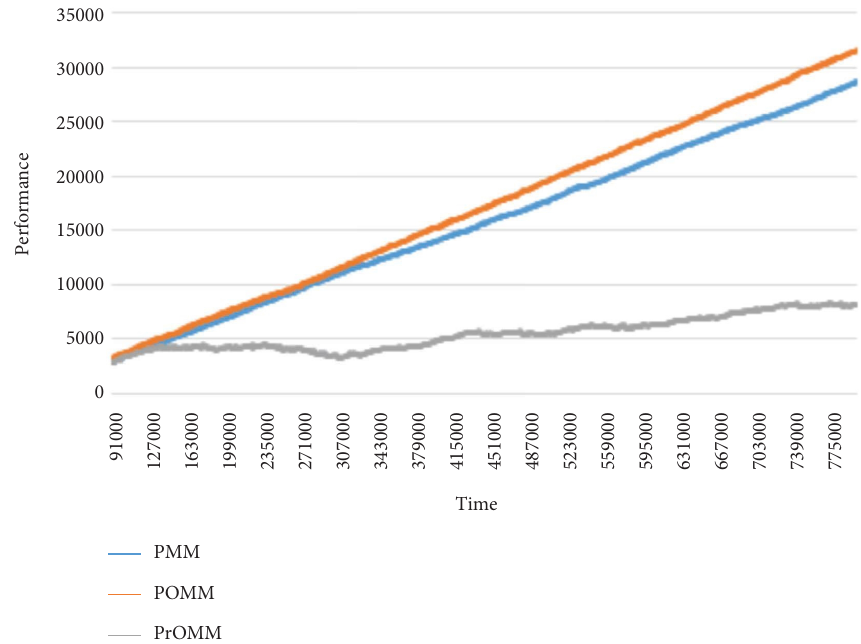
Figure 3: HFT agents’ performances in the stable market.